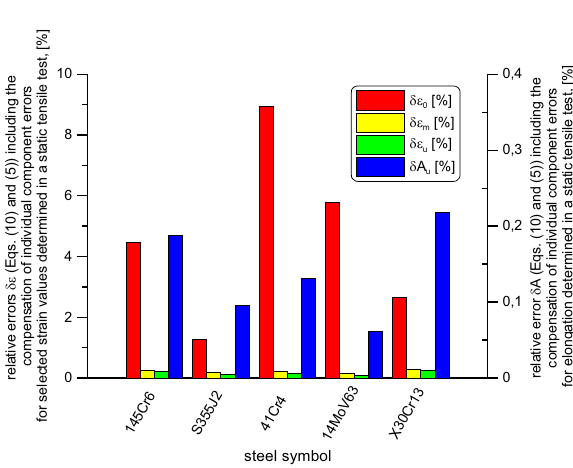
Figure 13: Comparison of the relative errors δε and Δ A including the compensation for individual errors of component quantities, for selected strain and elongation values using equations ( 10 ) and ( 5 )